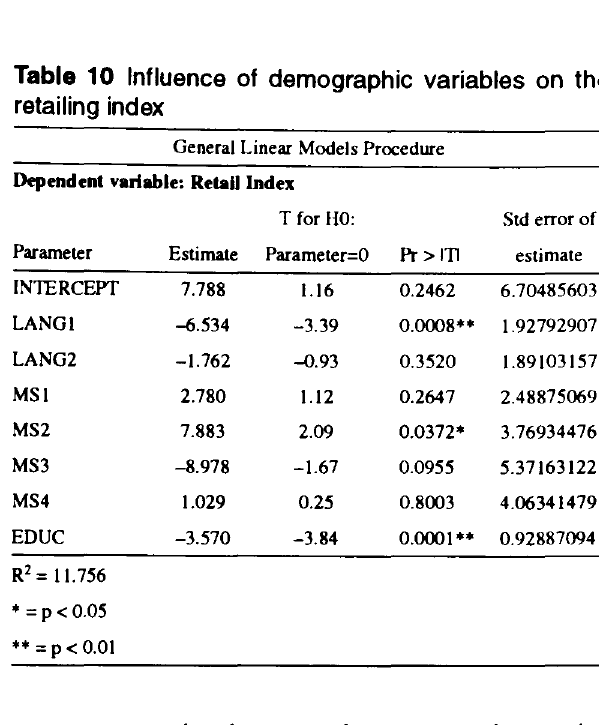
Table 10 Influence of demographic variables on the retailing